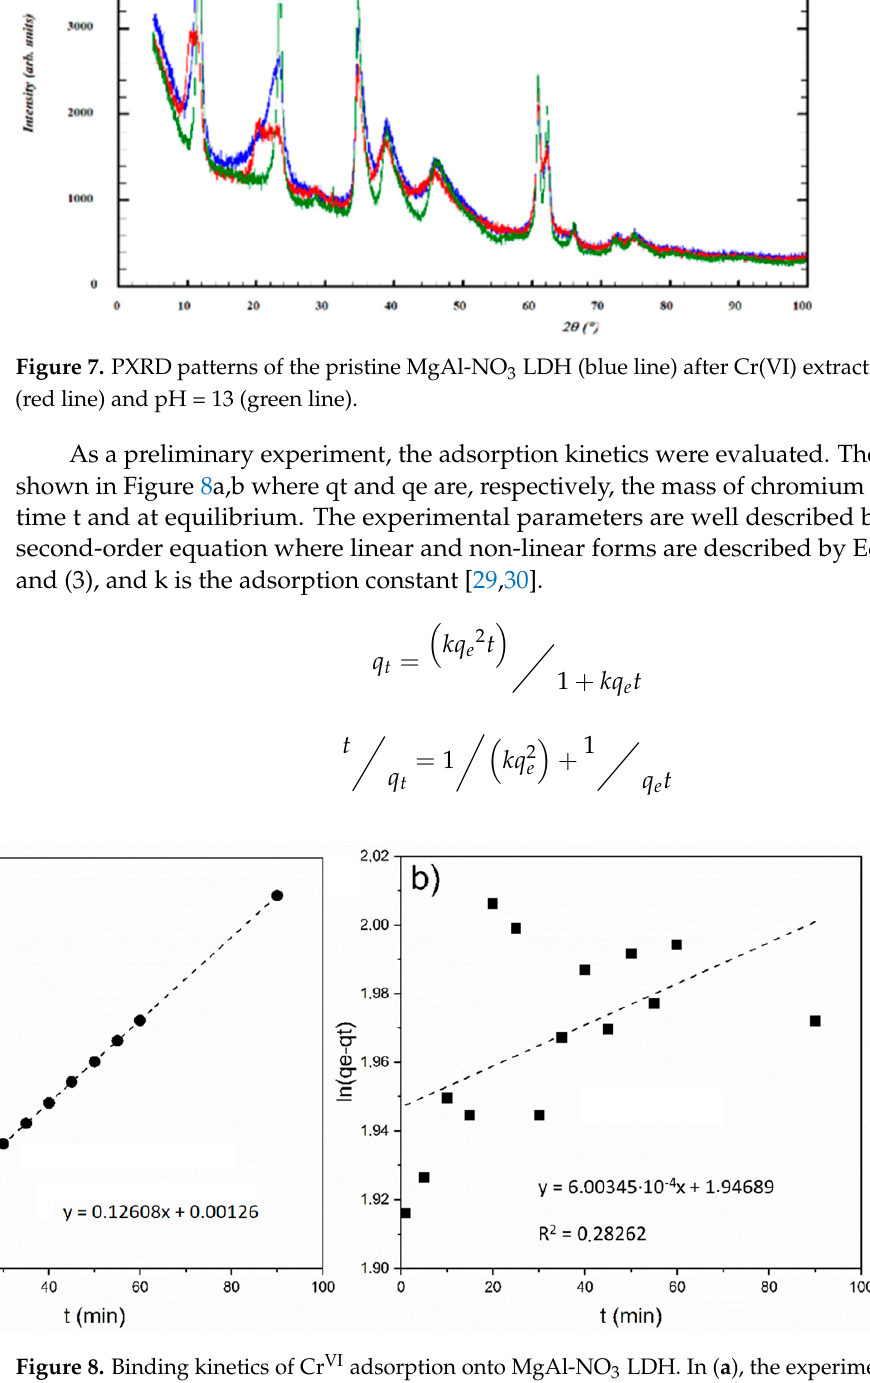
Figure 8. Binding kinetics of Cr VI adsorption onto MgAl-NO 3 LDH. In ( a ), the experimental data are fitted with a pseudo second-order kinetic model, whilst in ( b ), the experimental data are fitted with a pseudo first-order kinetic model.